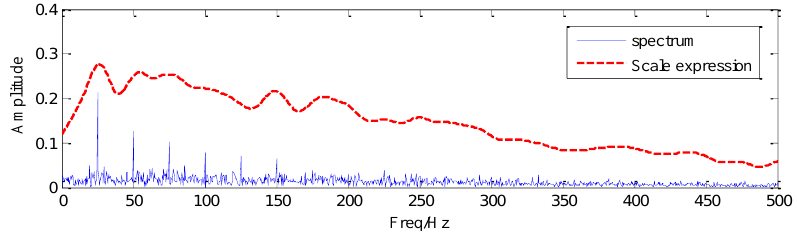
Figure 8. Spectrum and scale expression of the noisy simulated signal.